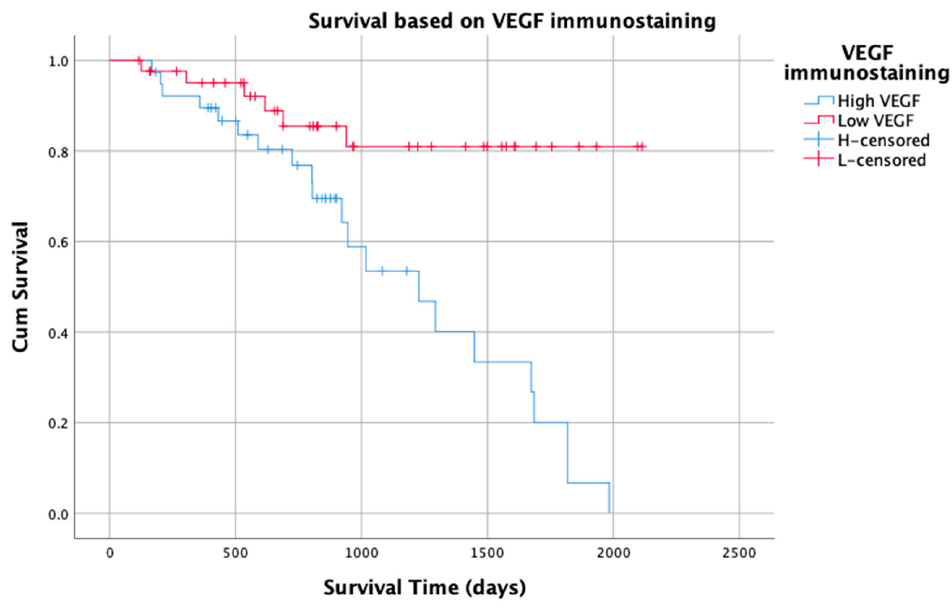
Figure 3. Kaplan–Meier graph of survival time for 82 patients with soft tissue sarcoma based on VEGF immunostaining (low and high).